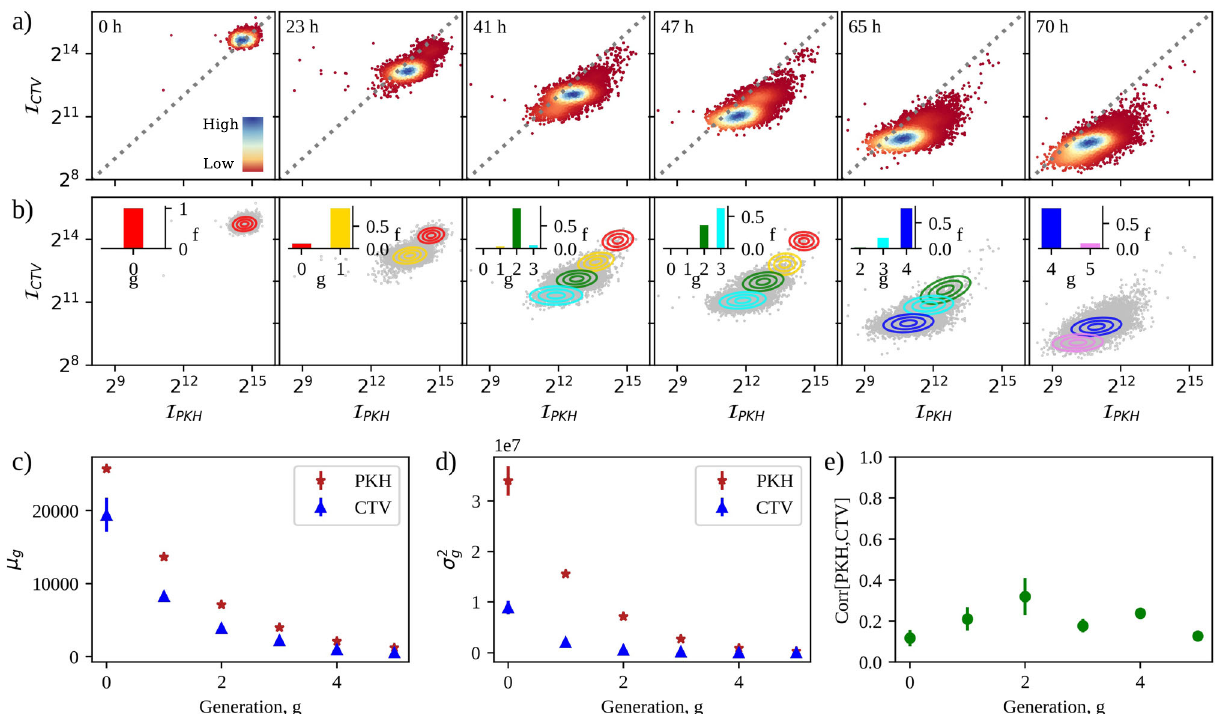
Fig. 2 Data analysis. a Dot plot of the intensity of PKH (PKH Linker, membrane lipid marker) vs CTV (CellTrace Violet, cytoplasm marker), measured at different times (hours) in one of the three experiments with simultaneous PKH and CTV markers. Points are colored from red to blue as the local density of points in the plot increases. Grey dashed lines mark the plane bisector. b Gaussian mixture fi t from the estimate model parameters obtained from ( a ). Experimental data are represented as gray dots, while the position of the best- fi t Gaussians are displayed by the concentric circles. Different colors correspond to different generations. The percentages, f , of cells in each generation, g , are reported in the insert as a bar plot. c Mean value of the intensity of the fl uorescent markers as a function of the generations, obtained through the Gaussian mixture fi tting. Blue triangles and red stars correspond to the mean of the intensity for cytoplasm and membrane dyes, respectively. The standard error of the mean is either represented with bars or is smaller than the size of the markers. d Same as in ( c ) but with the square root of the intensity variance. e Pearson correlations between the PKH and CTV intensities as a function of the generations. Green circles represent the mean correlation for each generation. The standard error of the mean is either represented with bars or is smaller than the size of the